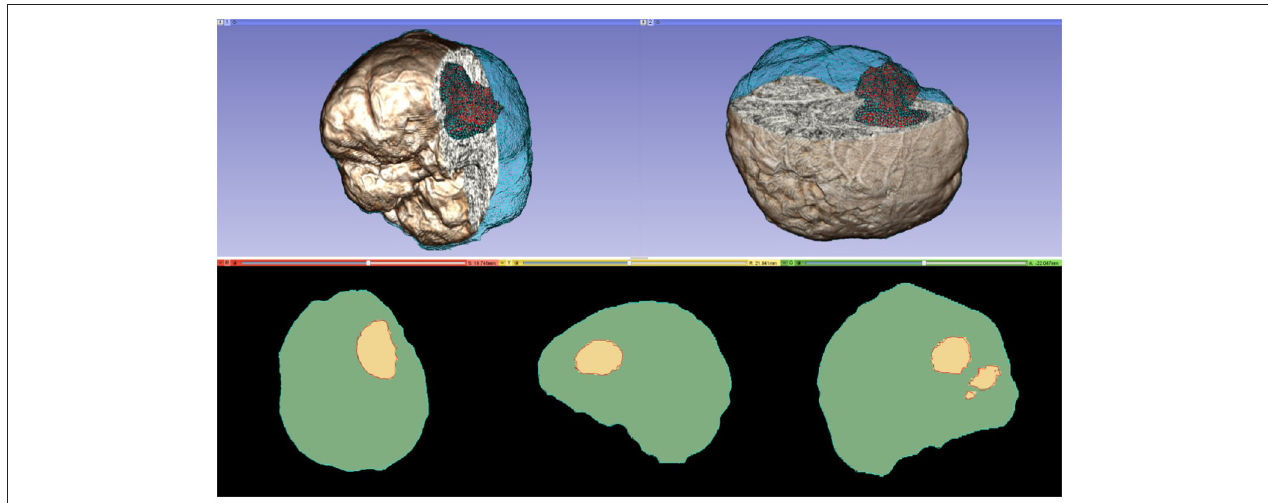
FIGURE 3 | A multi-tissue (brain parenchyma, tumor) finite element mesh used for non-rigid registration (number of tetrahedral elements: 160,179; minimum dihedral angle: 4.41 ◦ ). Top row: the mesh superimposed on a volume rendering of the MRI data. Cyan and red represent the brain parenchyma and tumor meshes, respectively. Bottom row: mesh fidelity illustrated on an axial, sagittal, and coronal slices. Each slice depicts a 2D cross-section of the mesh surface (cyan and red lines) and the segmented volume (green and yellow regions). The closer the mesh surface is to the segmented boundaries, the higher the mesh fidelity.